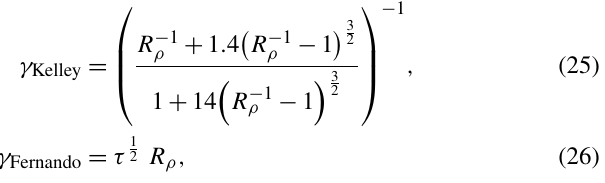
Table 1. The dimensions, properties, and consequent stability parameters applied in the case studies. Up and Down refer to the upper and lower layer of the dual-layered system (in Cases 5 to 7, the lower temperatures and salinities are properties of the central inflow). Dimension (m) T ( ◦ C) S (weight ‰) w in (ms − 1 ) T u ( ◦ ) R ρ – Case − Depth Radial Up Down Up Down 1 0.7 3.0 10 20 0 15 – 53 . 3 0.15 − 2 0.7 3.0 10 34 0 15 – 20 – 4 0.7 3.0 20 15